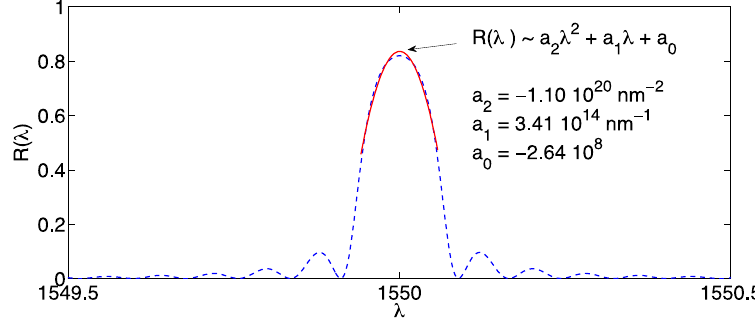
Figure 7. Sketch of the second-order polynomial fit peak tracking; interpolated spectrum is shown in red.